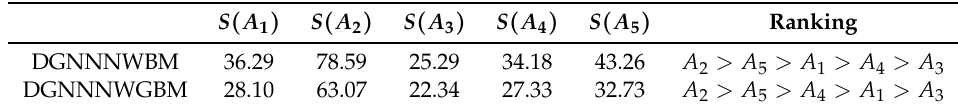
Table 6. The score of the